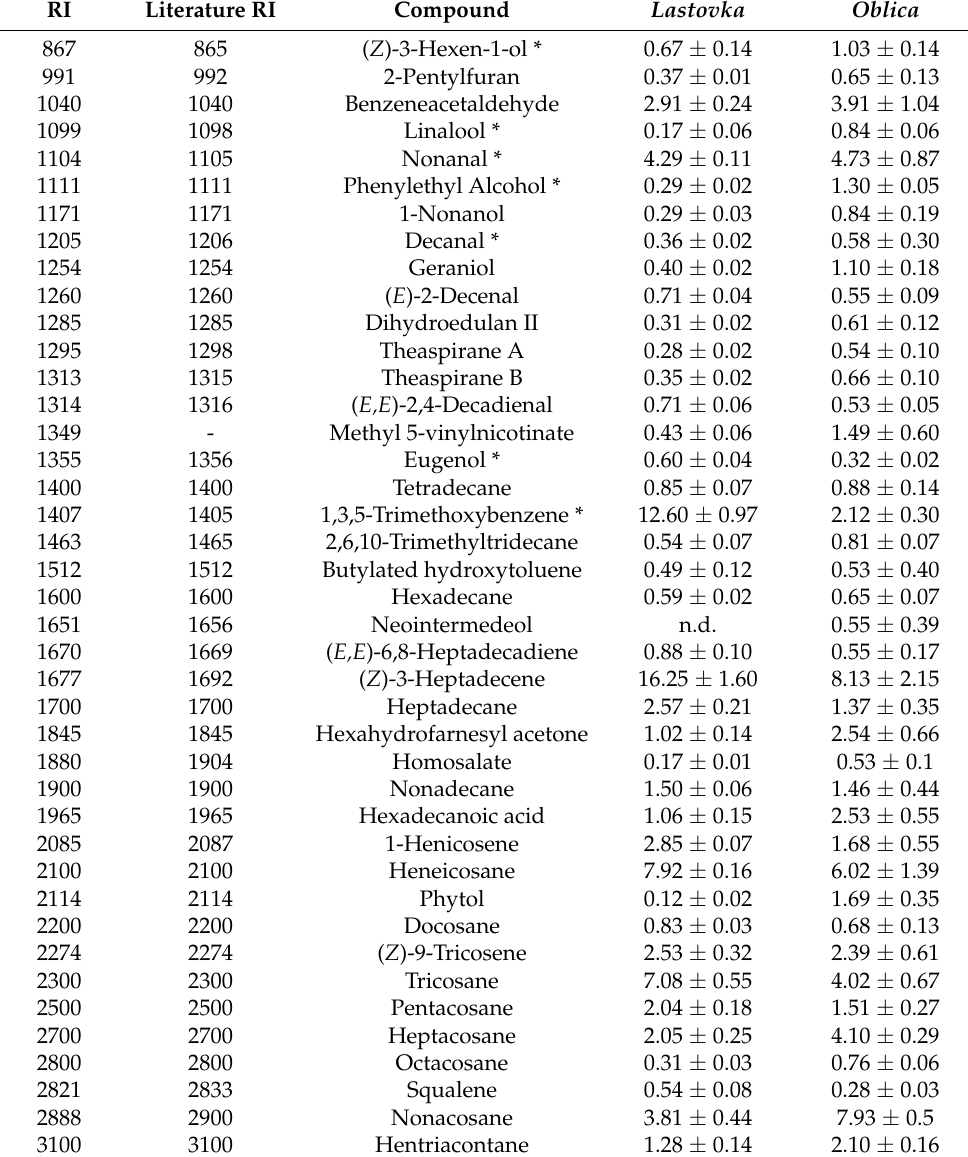
Table 1. Composition of volatiles identified in essential oils of olive vegetative buds from cvs. Lastovka and Oblica